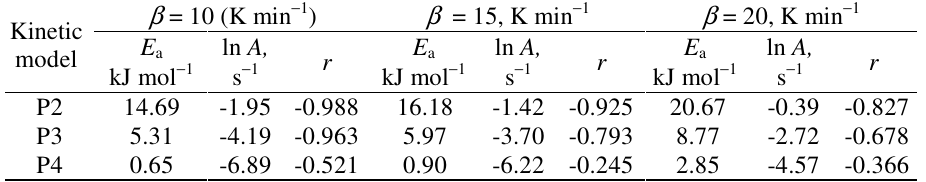
Table 4. Kinetic parameters for the third stage decomposition of